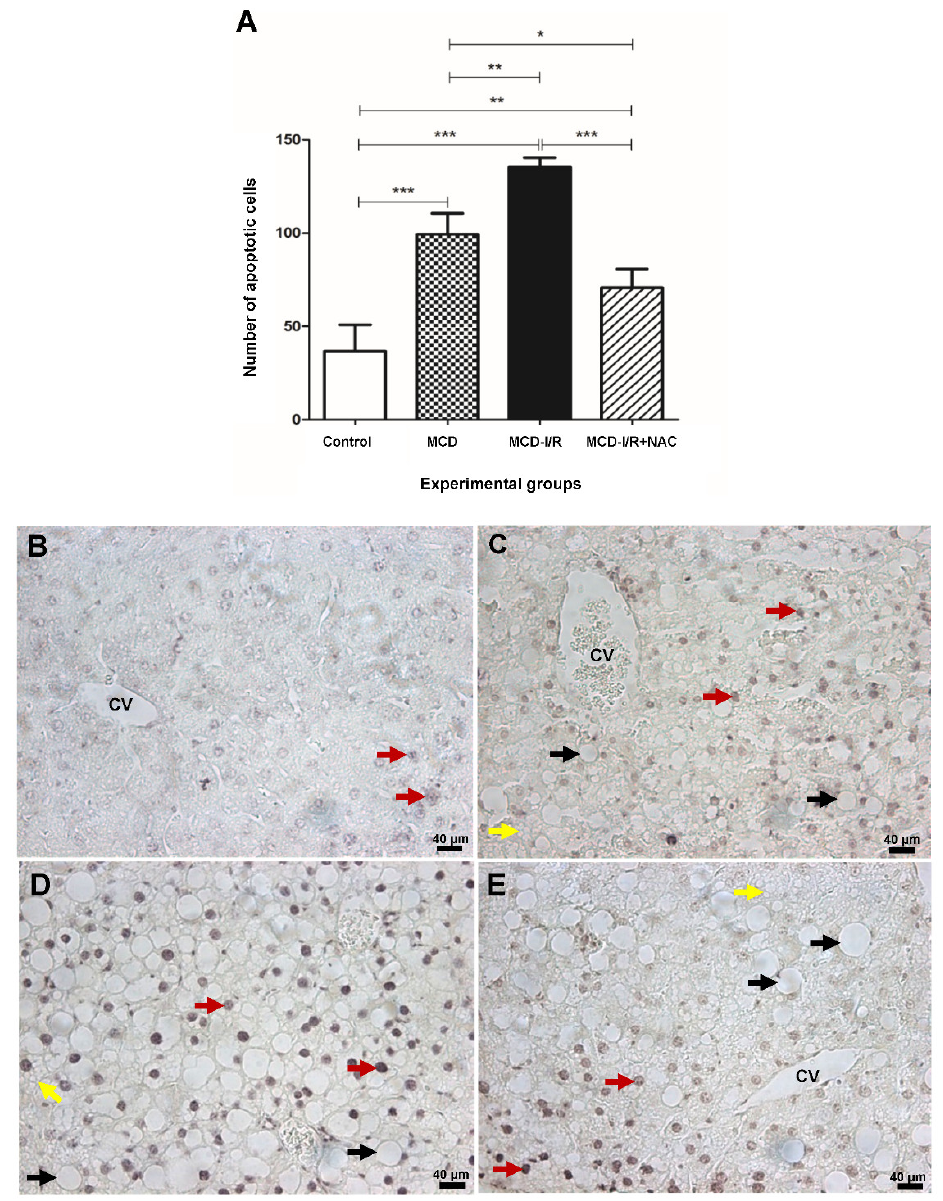
Figure 6. Apoptosis in mouse livers with steatohepatitis submitted to I/R and the effect of N -acetylcysteine on hepatic tissue. In ( A ), the results of statistical comparisons among the experimental groups are presented, where * p < 0.05, ** p < 0.01, and *** p < 0.001. The photomicrographs (magnification of 40×). ( B ) Control group. ( C ) MCD group. ( D ) MCD-I/R group. ( E ) MCD-I/R+NAC group. The red arrows indicate apoptotic cells detected by the TUNEL technique, the black arrows indicate the presence of macrovesicular steatosis, and the yellow arrows indicate microvesicular steatosis. CV = central vein.